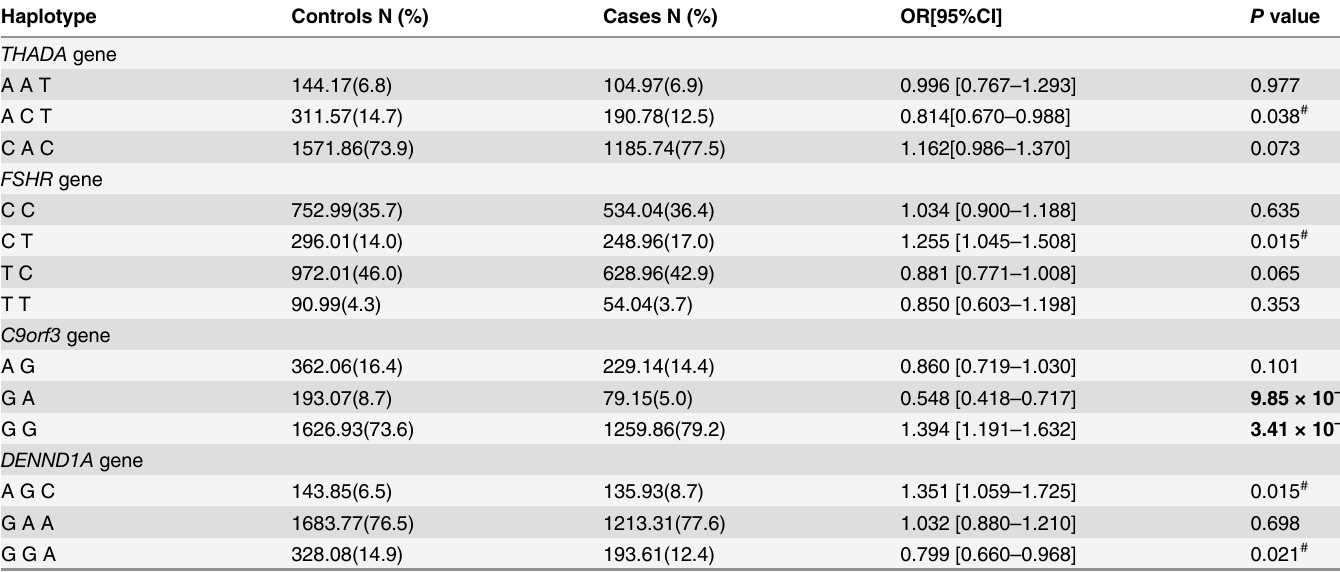
Table 4. Haplotype analysis of THADA gene, FSHR gene, C9orf3 gene and DENND1A gene between the controls and the cases.